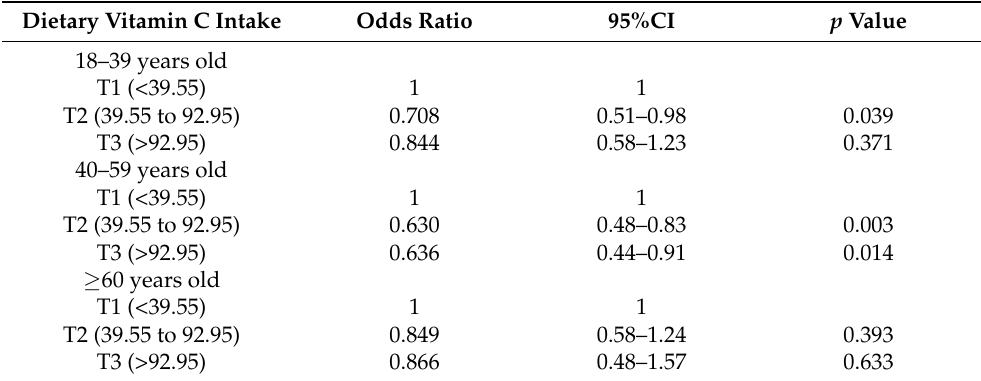
Table 4. Association between dietary vitamin C intake and depressive symptoms after age stratification. Dietary Vitamin C Intake Odds Ratio